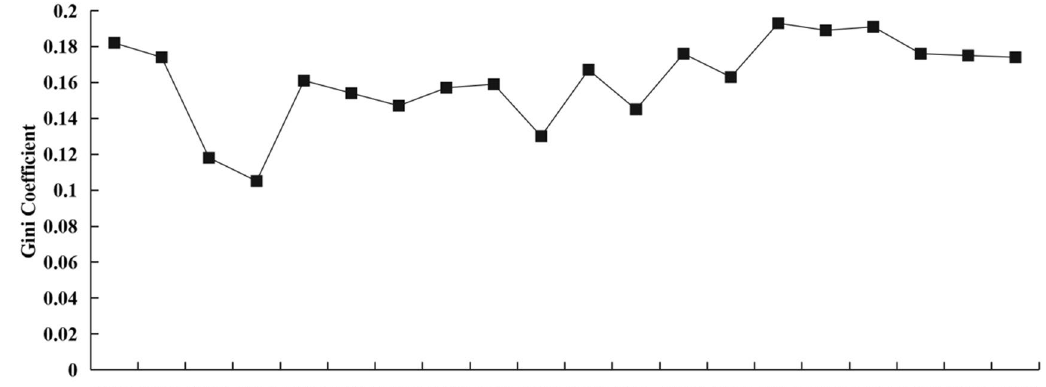
Figure 6. The total difference of